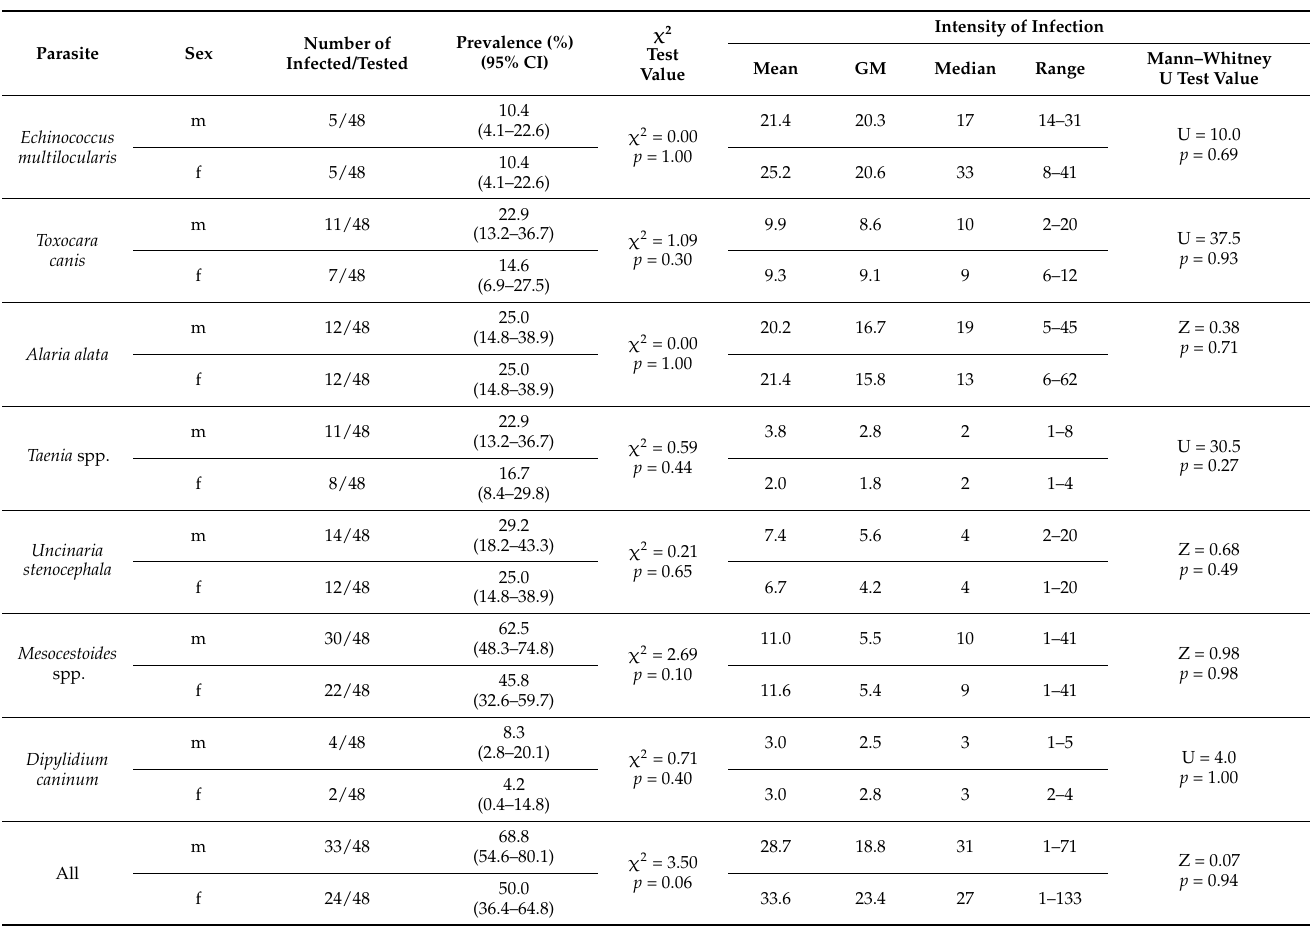
Table 2. Prevalence of gastrointestinal parasites in raccoon dogs with regard to host sex (m—male,